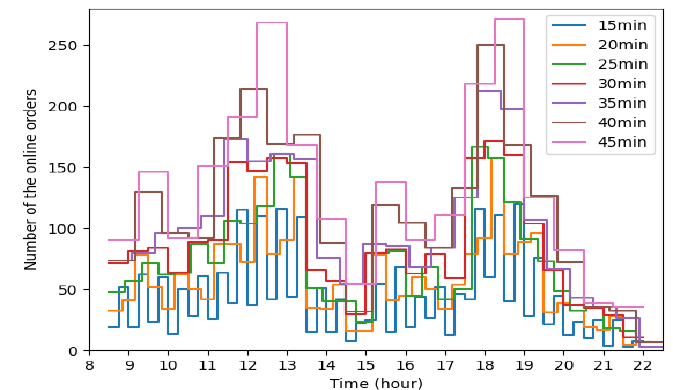
Fig. 10. The distribution character of online orders with the different committed delivery time.